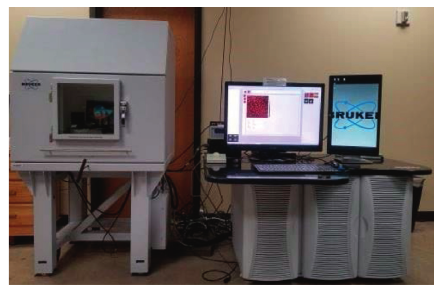
Figure 4: Atomic force microscopy (AFM).